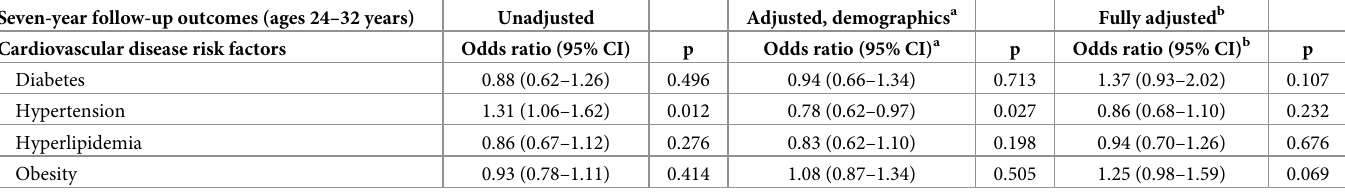
Table 3. Associations between legal performance-enhancing substance use and binary clinical cardiovascular disease risk factor outcomes among young adults at seven-year follow-up. Seven-year follow-up outcomes (ages 24–32